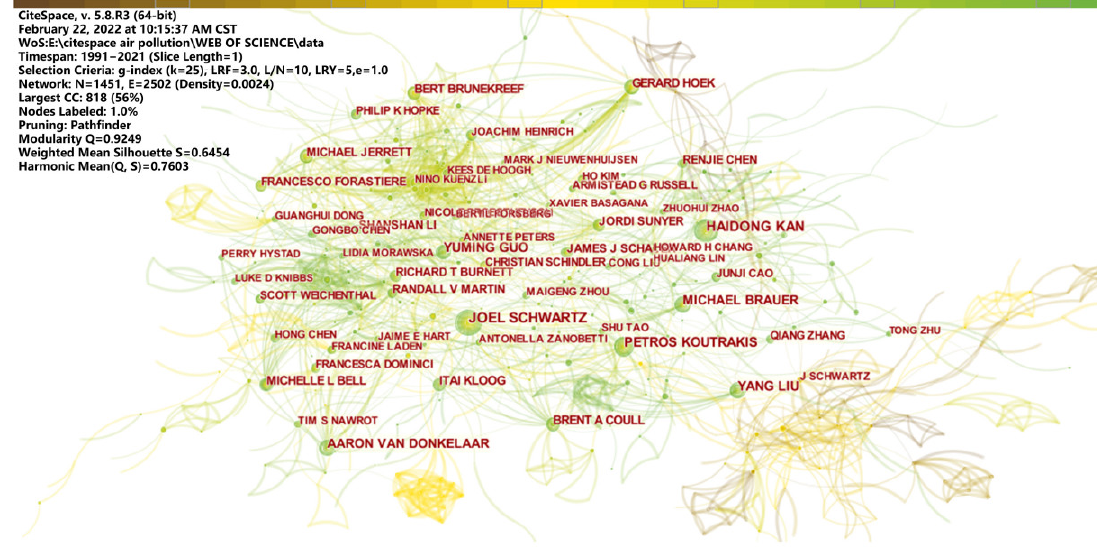
Figure 4. English literature author cooperative network.